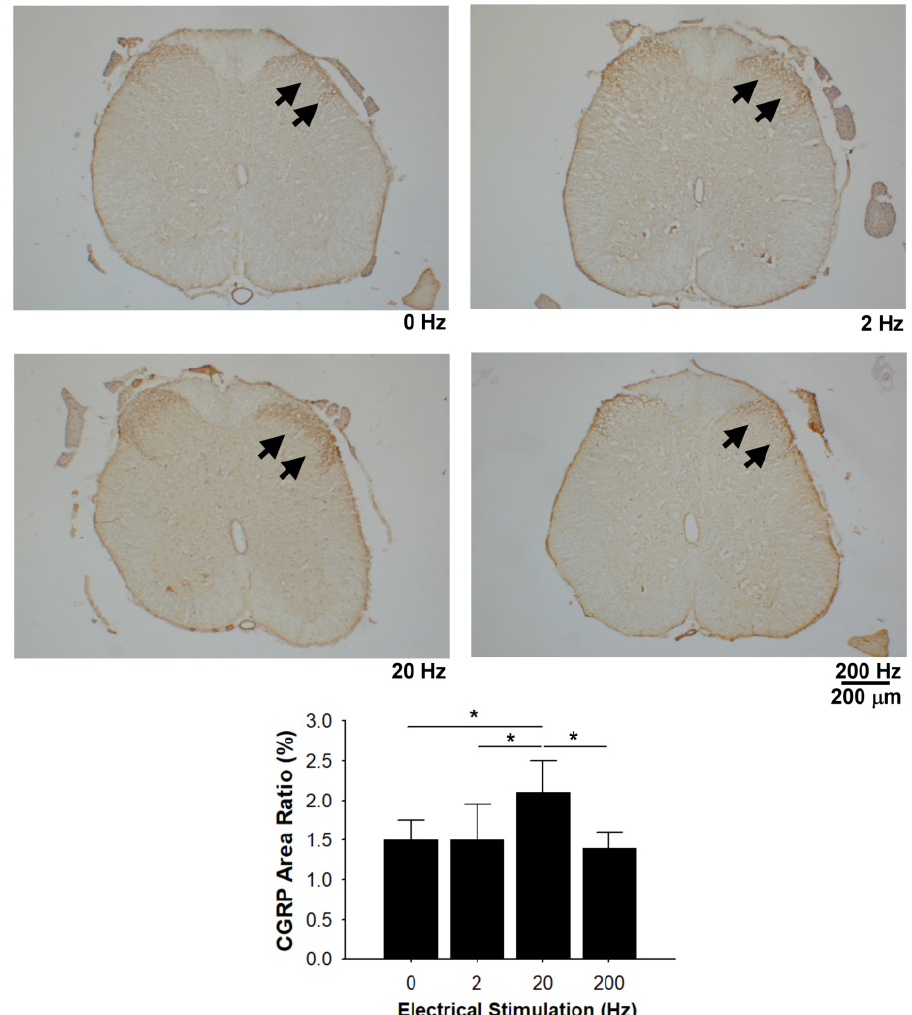
Figure 9. Effects of electrical stimulation on calcitonin gene-related peptide (CGRP) expression in taxol-treated rats. Representative images of CGRP-labelled fibers (arrows) and comparison for the ratio of CGRP expression area. *Significant differences between conditions, P < 0.05. Scale bar = 200 μ m.